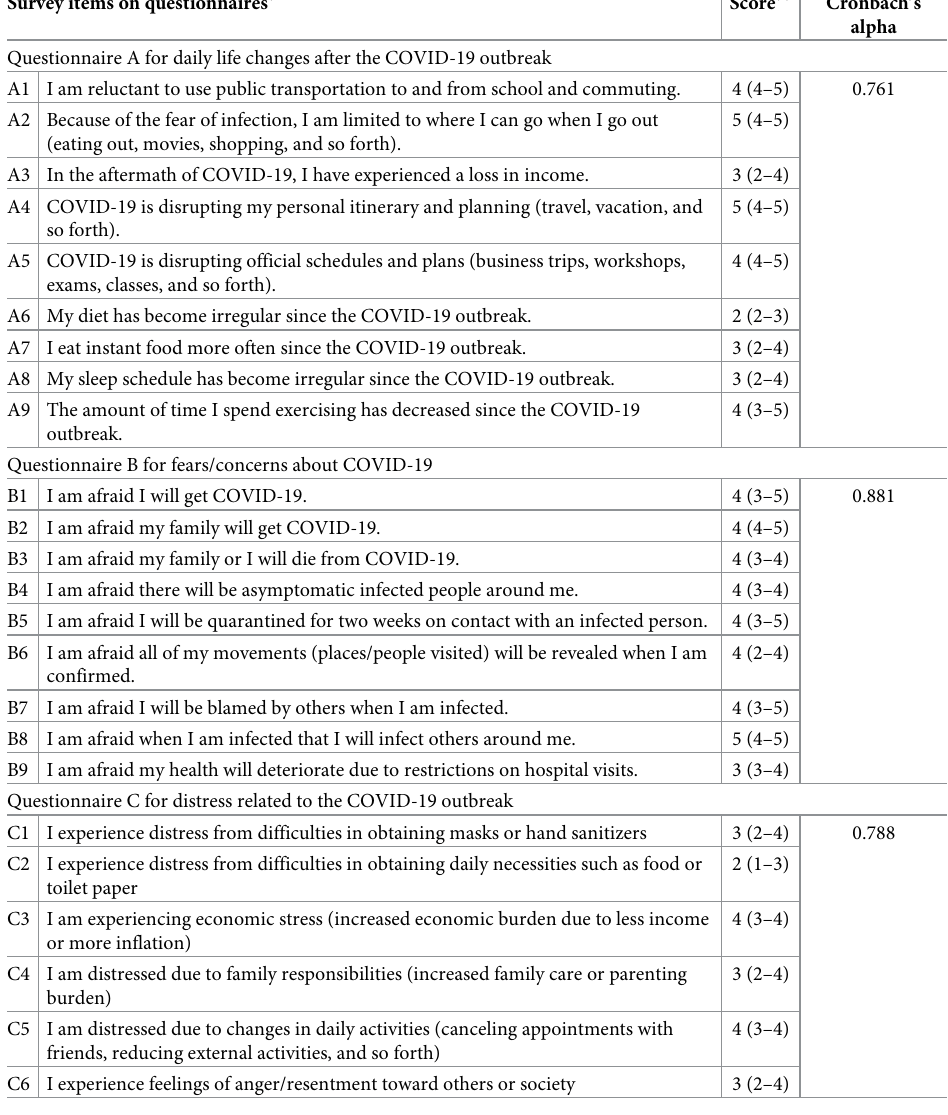
Table 1. Daily life changes, fear, and distress related to the COVID-19 outbreak in 1,500 Koreans. Survey items on questionnaires � Score �� Cronbach’s